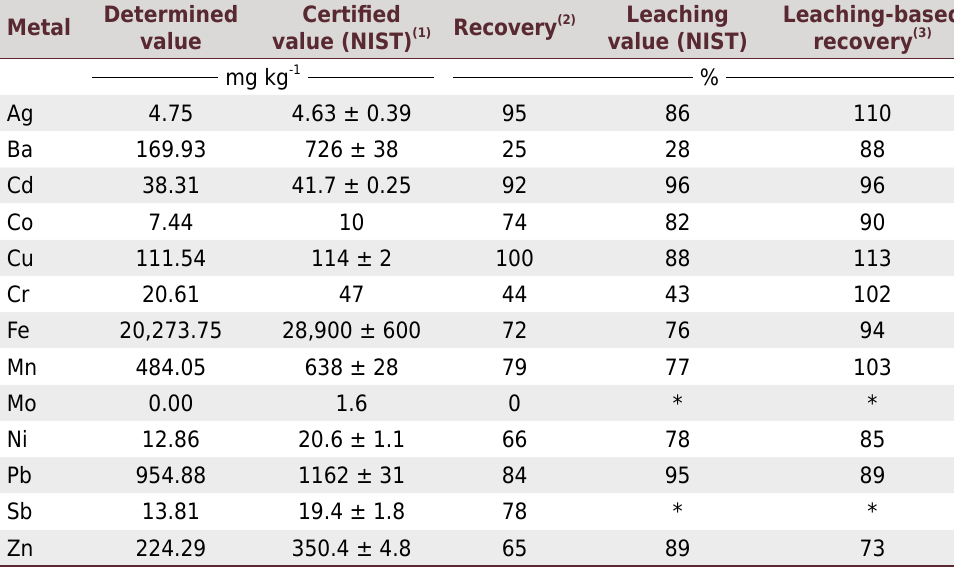
Table 3. Recovery of heavy metals in the reference soil (SRM 2711 – Montana) based on the Usepa method 3051A (n = 4)